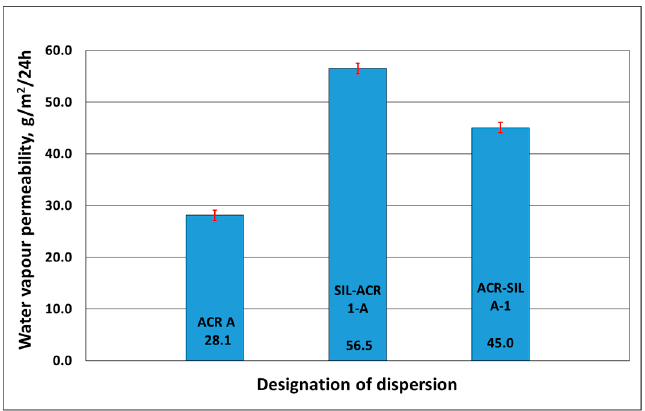
Figure 14. Comparison of water vapour permeability determined for starting acrylic/styrene copolymer dispersion (ACR A) and hybrid dispersions ACR-SIL A-1 and SIL-ACR 1-A having the same composition of SIL and ACR parts.